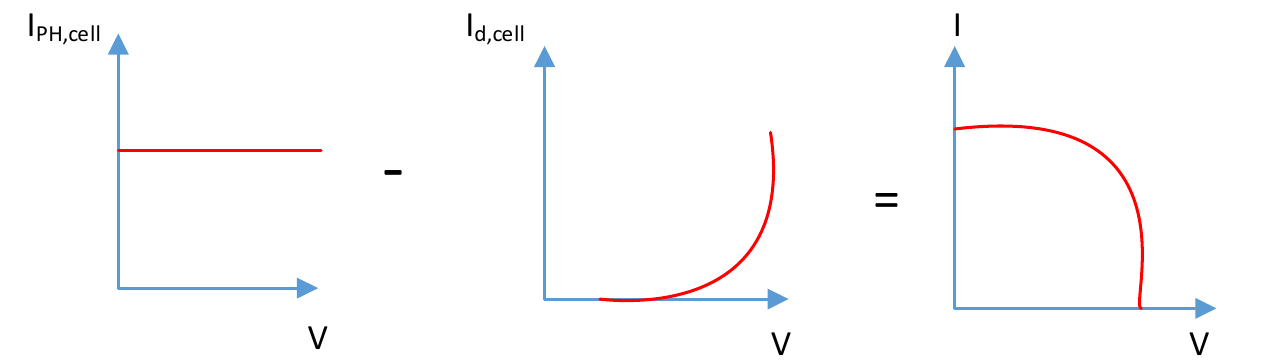
Figure 2. The circuit of a photovoltaic cell based on a single-diode mode.